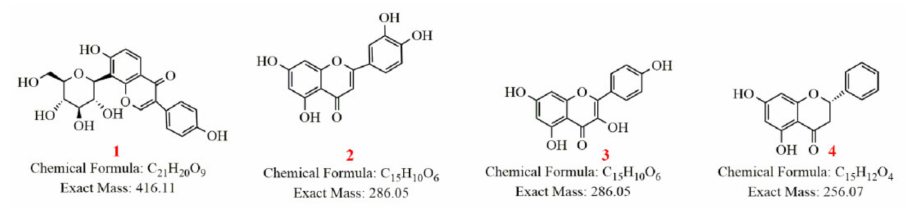
Figure 4. Structure of four representative flavonoids from aerial parts of Glycyrrhiza uralensis ; 1—puerarin (isoflavones); 2—luteolin (flavonoids); 3—kaempferol (flavonol); 4—pinocembrin (flavone). Table 2. Distribution of four representative flavonoid metabolites in